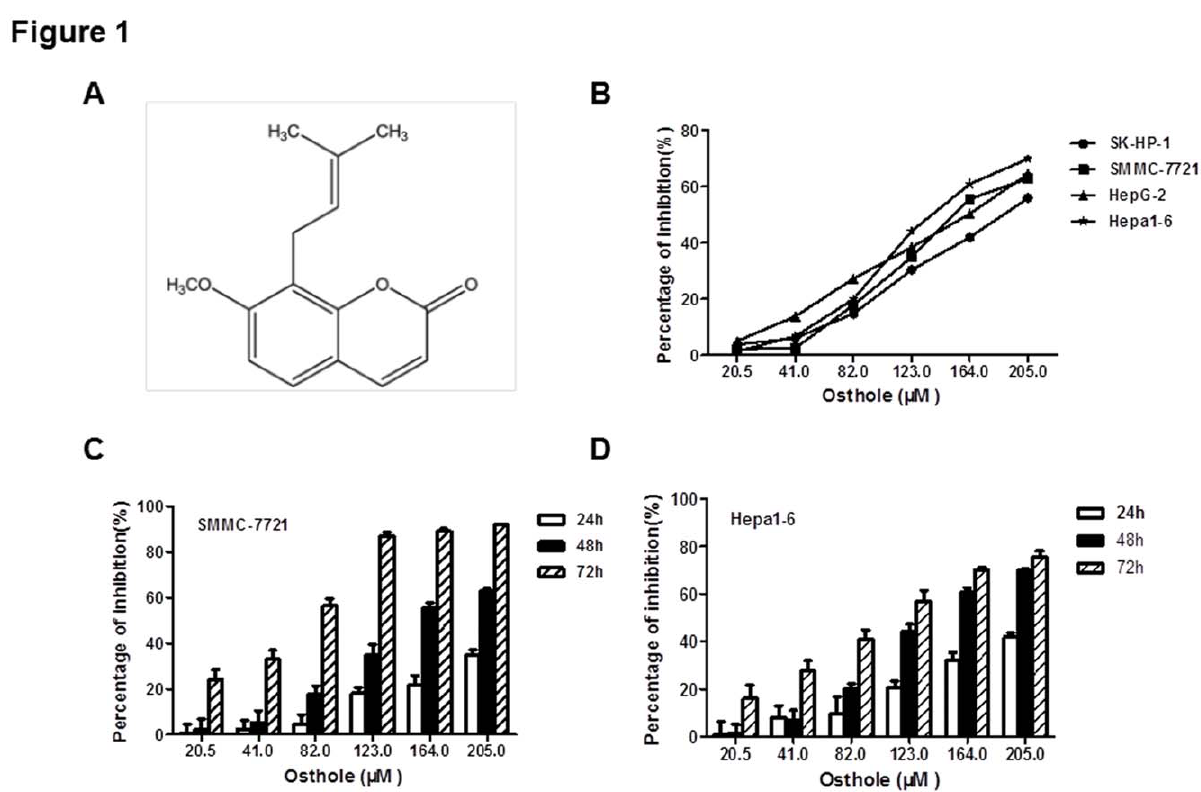
Figure 1. Osthole Inhibited Cell Proliferation of HCC Cell Lines. (A) Chemical Structure of osthole (B) Viability of SK-HP-1, SMMC-7721, HepG-2 and Hepa1-6 cells treated with osthole. MTT assay was performed to measure cell growth inhibition rate at 48 h after osthole treatment. (C)(D) Viability of SMMC-7721 and Hepa1-6 cells treated with osthole. MTT assay was performed to measure cell growth inhibition rate at 24 h, 48 h and 72 h after osthole treatment. Data shown were representatives of three